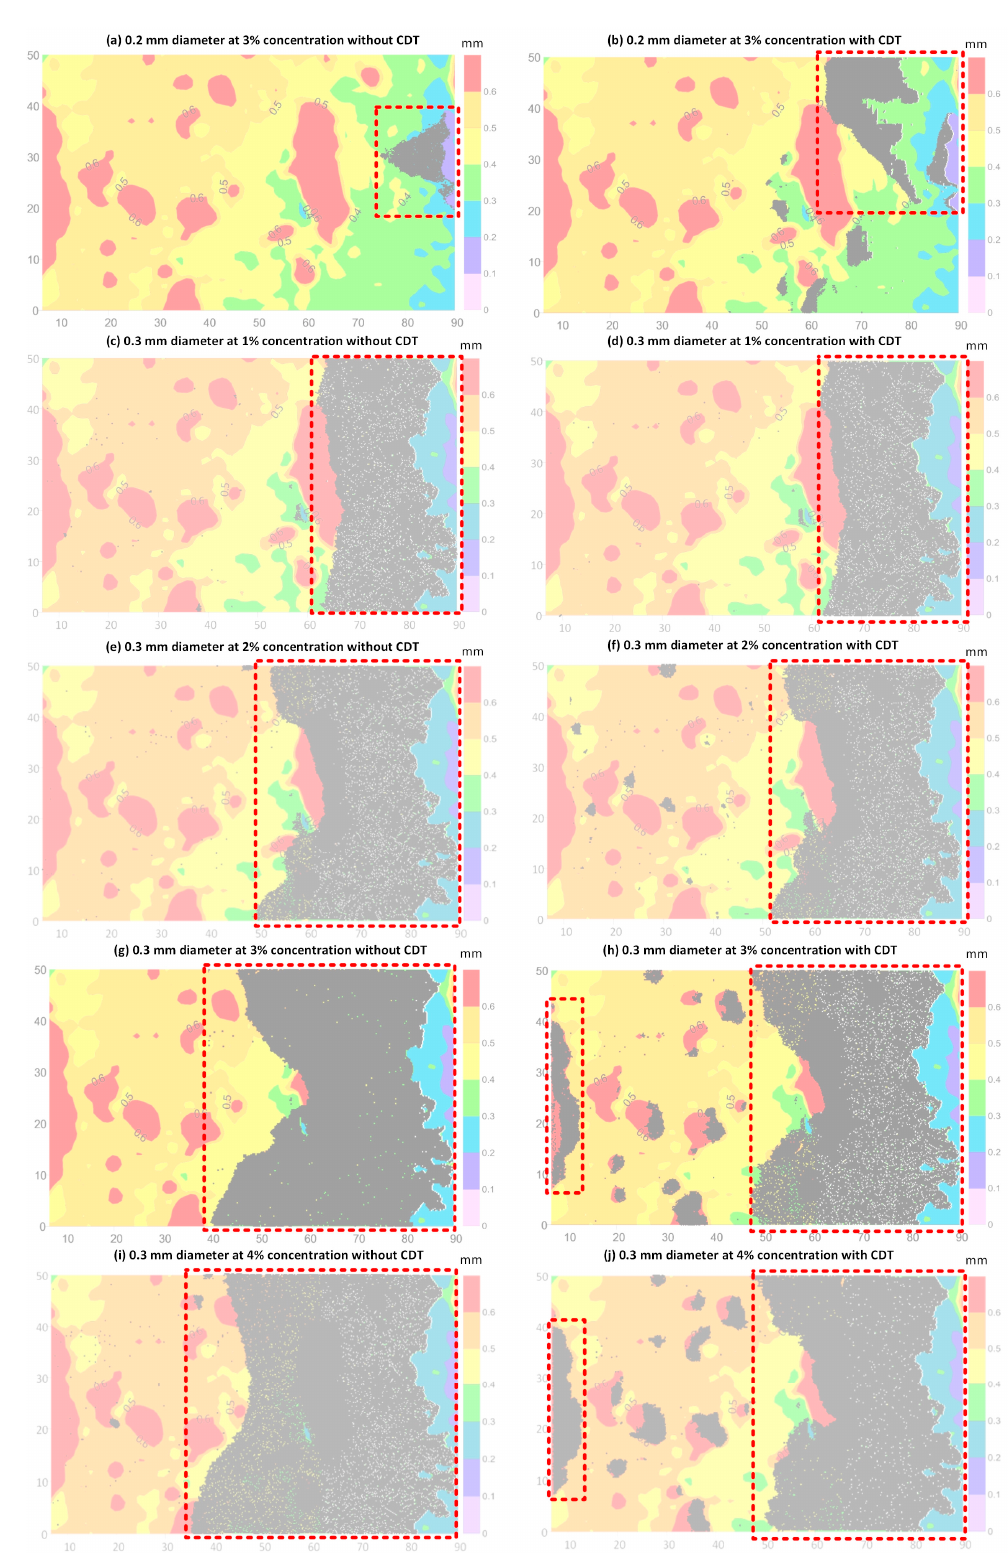
Figure 16. The effect of LCM shape on plugging.